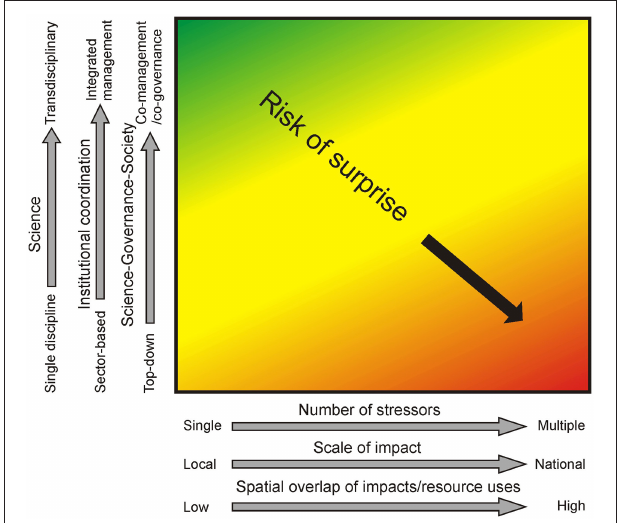
FIGURE 2 | Inter-connections between science, governance, and society that drive our ability to manage for socio-ecological